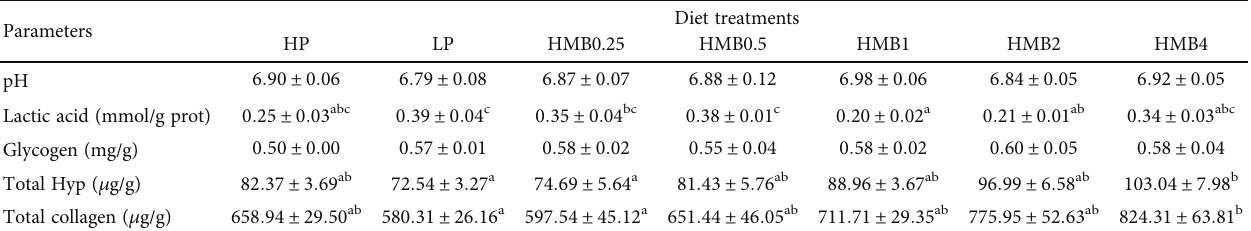
Table 8: The pH, contents of lactic acid, glycogen, total hydroxyproline and collagen in muscle of kuruma shrimp fed with the experimental